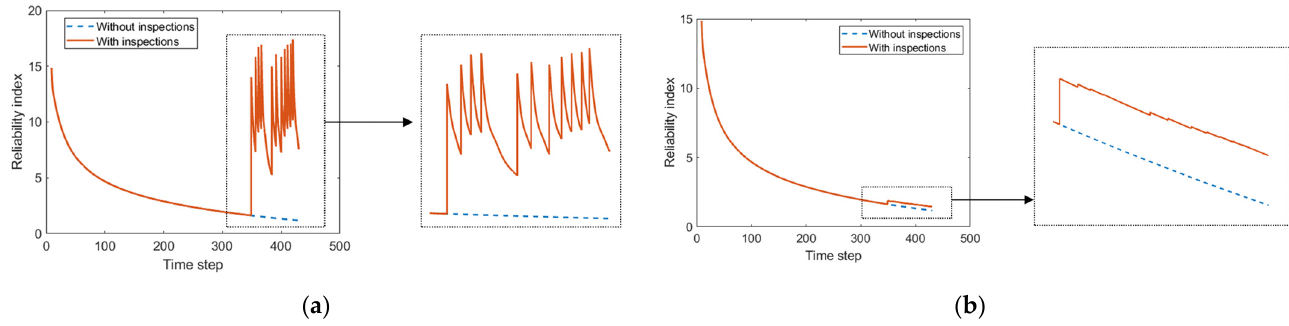
Figure 18. Reliability index changes of inspected and uninspected components considering the inspection data of fatigue cracks. ( a ) Inspected component. ( b ) Uninspected component.